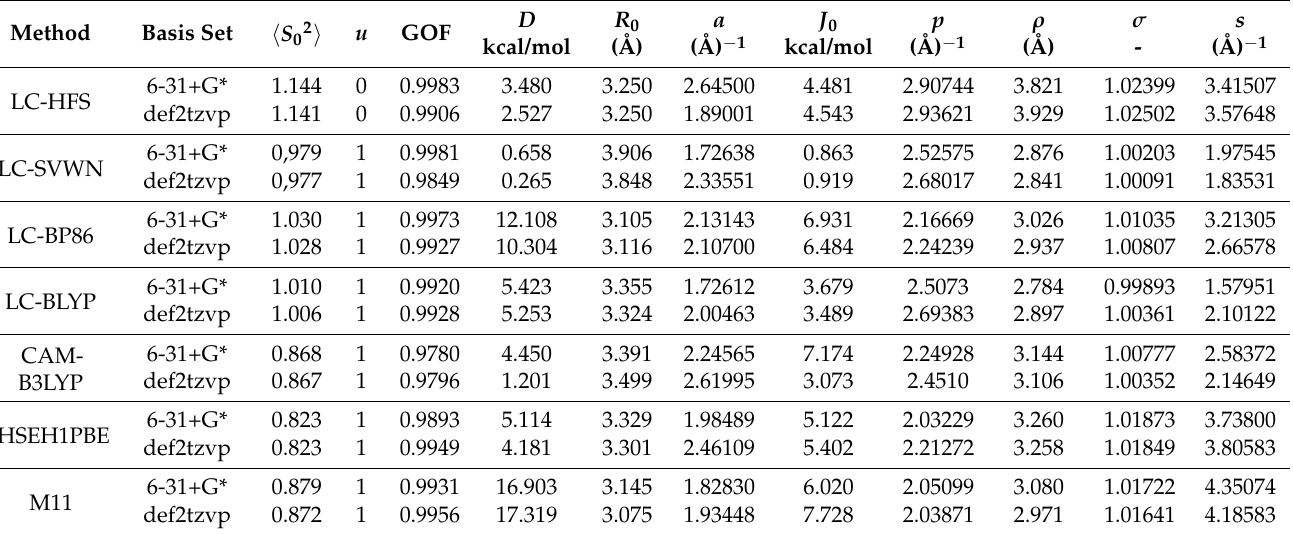
Table 2. Bonding and spin Hamiltonian parameters from handling data from range-corrected functionals. The meaning of the quantities is the same as in Table